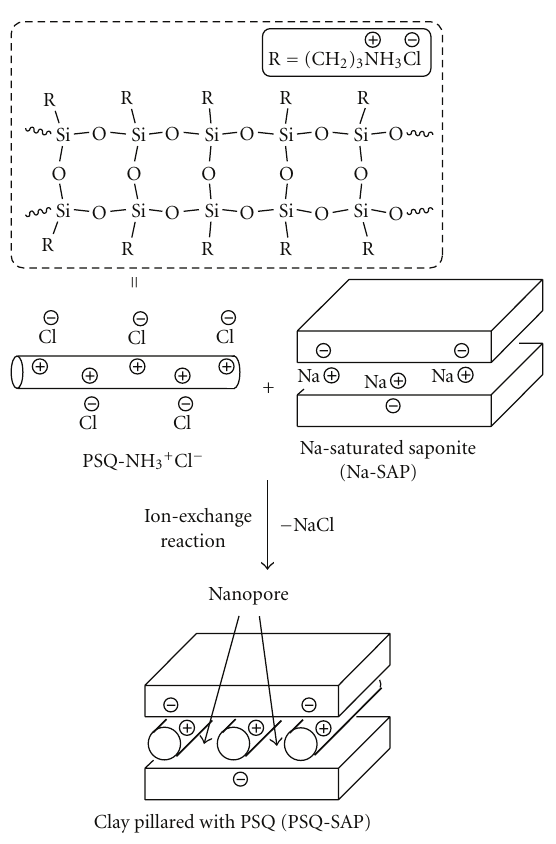
Scheme 6: Preparation of a clay pillared with PSQ by ion-exchange reaction of PSQ-NH 3+ Cl − with Na-saturated